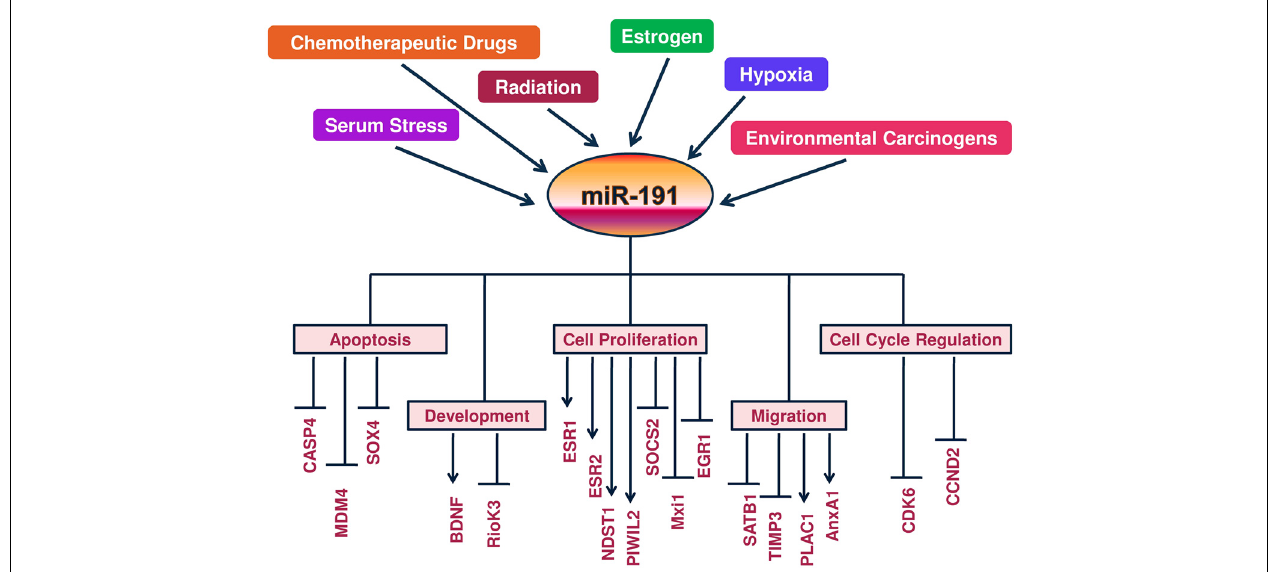
controls the expression of a number of genes involved in a variety of cellular processes (ranging from cell proliferation to apoptosis to cell migration) to modulate the development of cancer. Overall, miR-191 integrates multiple pathogenic signals to regulate cancer